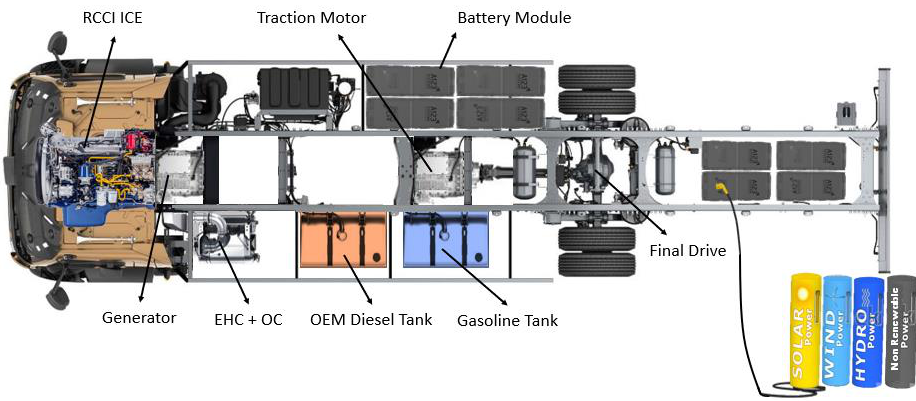
Figure 1. Truck powertrain layout for the plug-in hybrid dual fuel version.